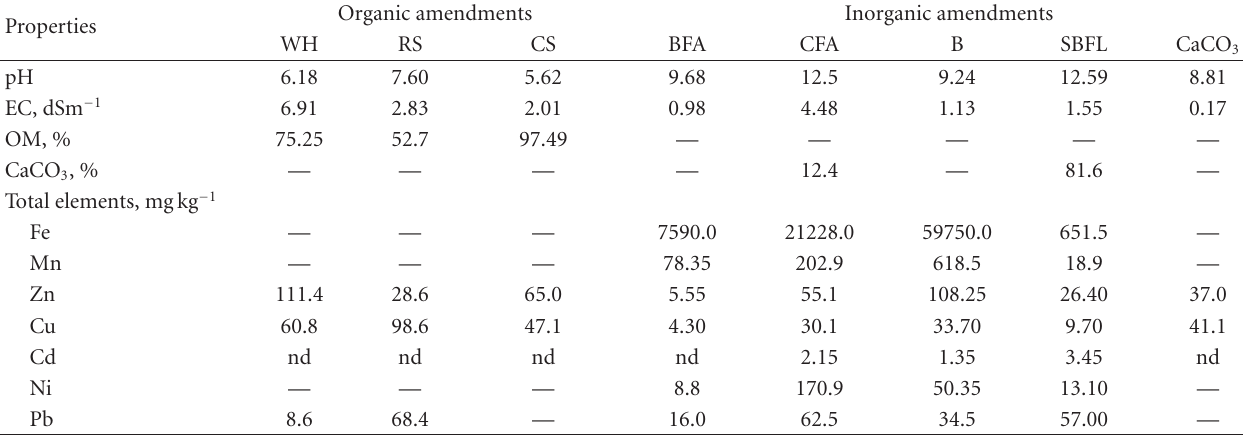
Table 3: Selected characteristics and metal concentrations in the studied amendments. Properties